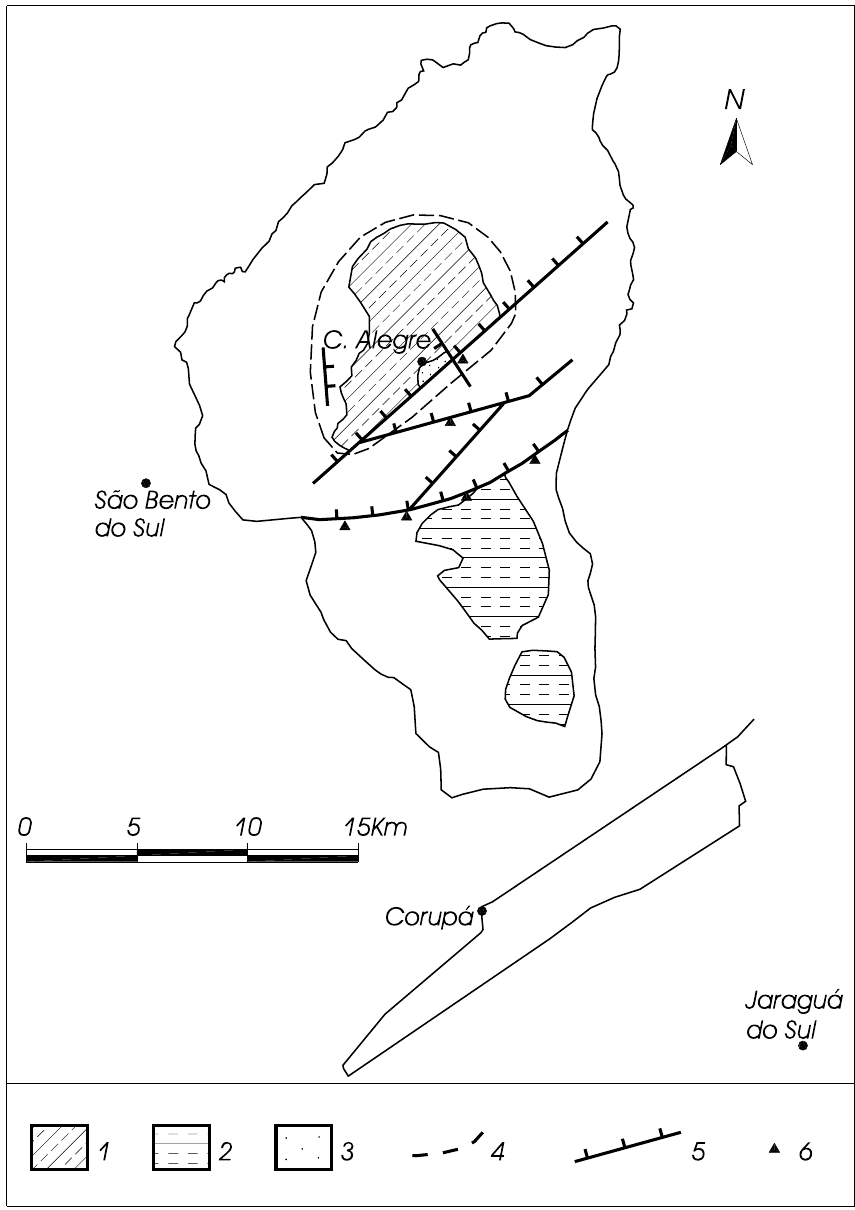
Fig. 6 – Paleogeography of the caldera stage of the Campo Alegre Basin, showing the outcropping area of the intra- and extra-caldera units: 1)- Rio Turvo Formation; 2)- Arroio Agua Fria Formation; 3)- Fazenda Uirapuru Formation; 4)- Caldera limit; 5)- extentional faults; 6)- volcanic